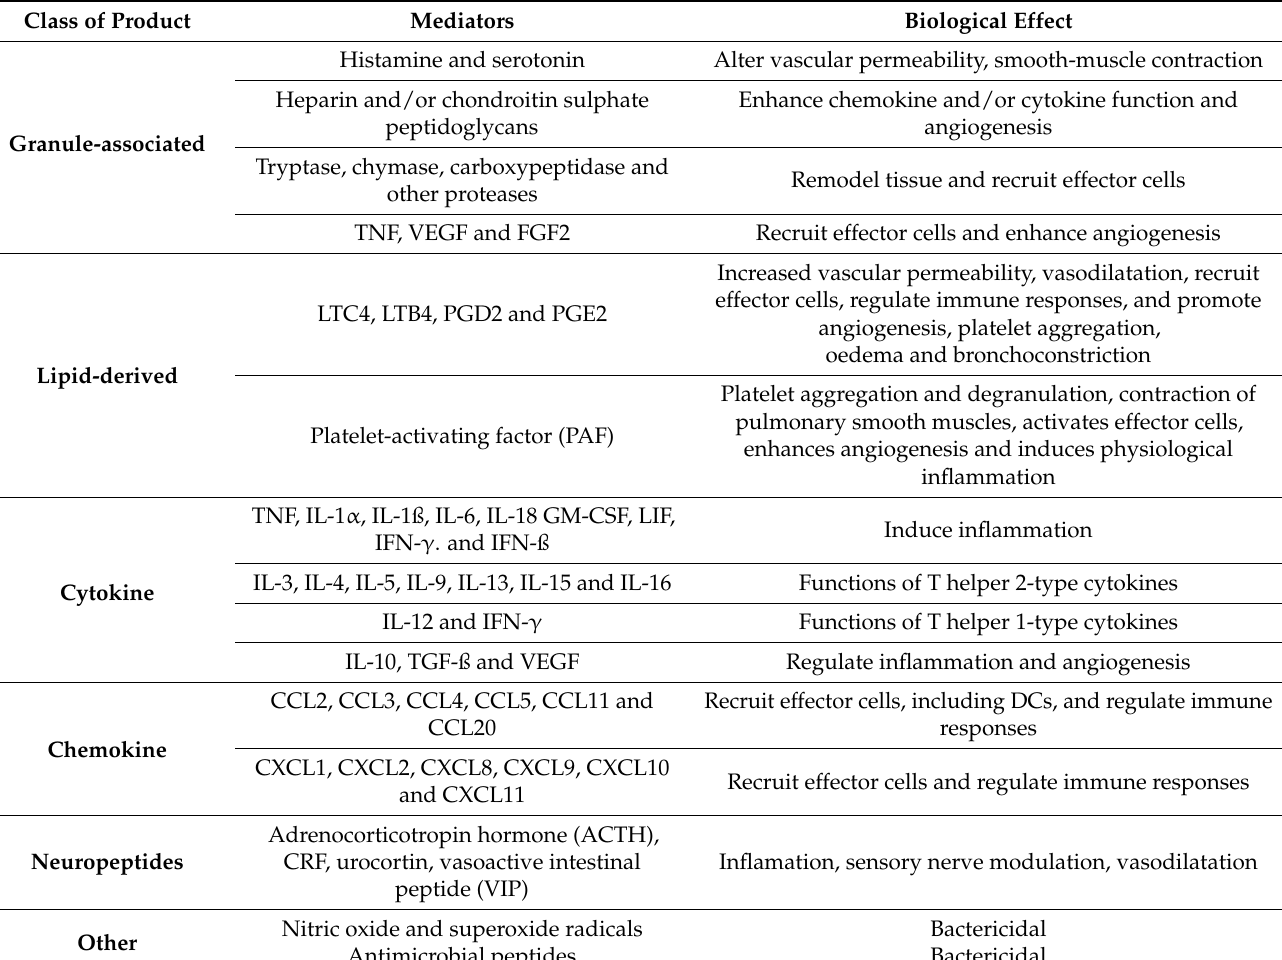
Table 6. Main classes of mediators that are released by mast